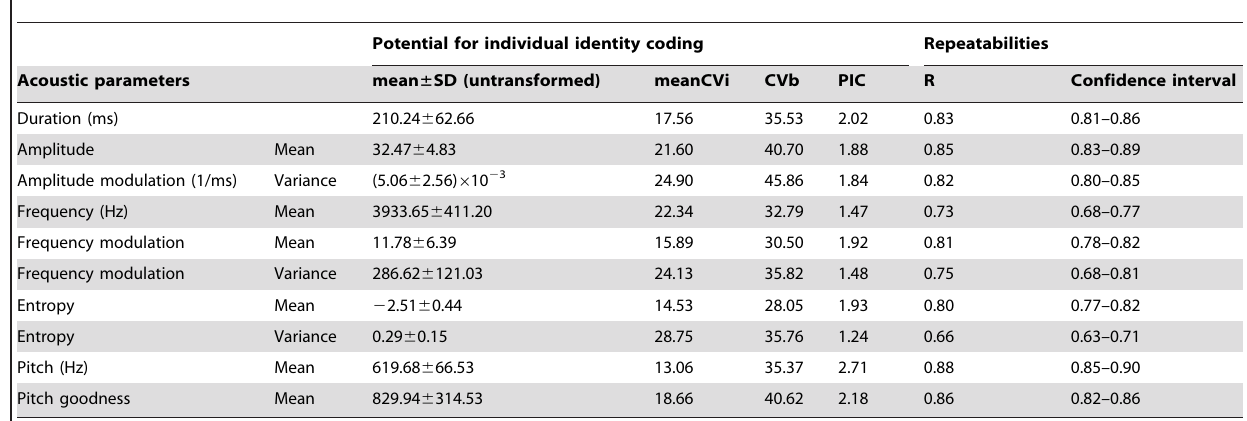
Table 1. Potential for individual identity coding and repeatabilities for ten acoustic parameters from 493 calls of 84 individuals.